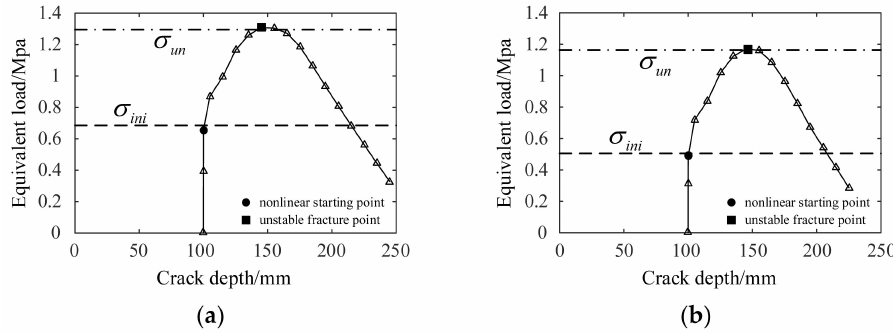
Figure 12. The curve of the equivalent load–crack depth: ( a ) arch crown, ( b ) arch